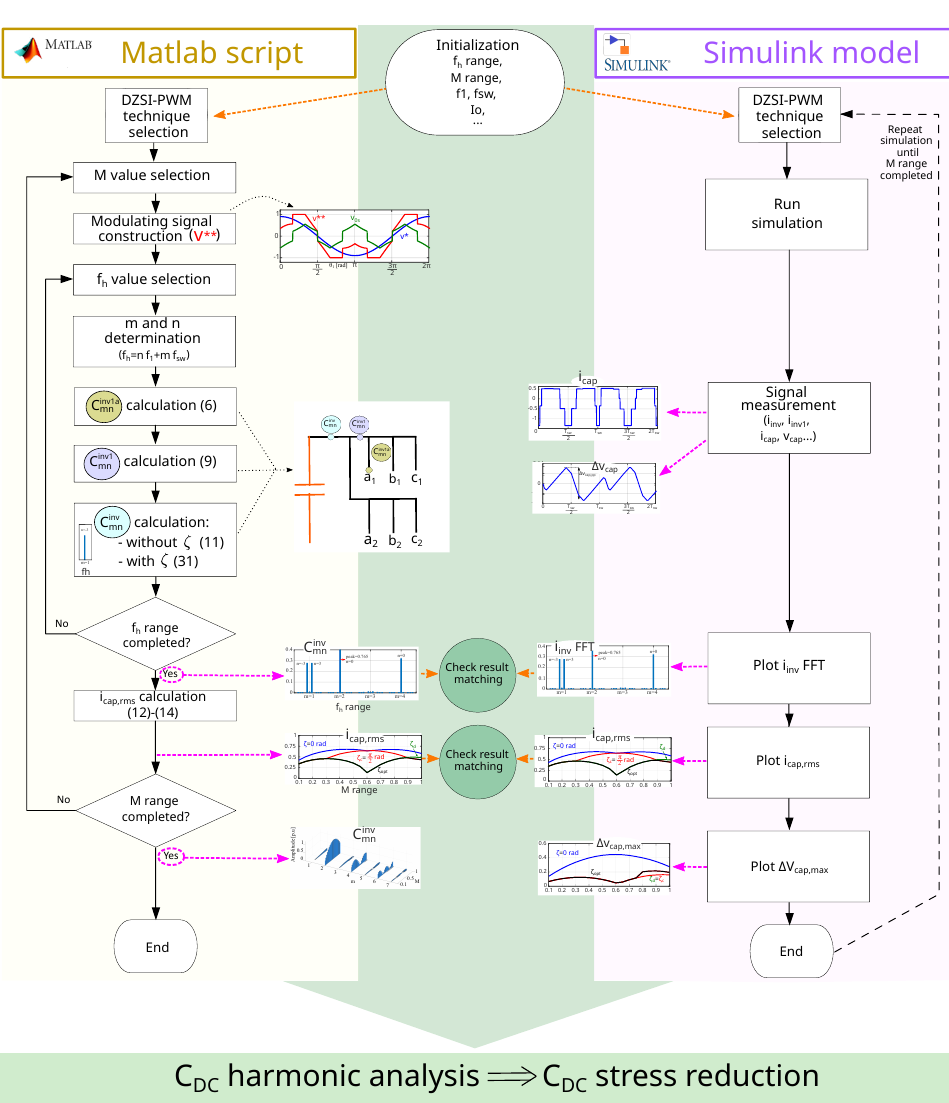
Figure 3. C DC harmonic analysis and rms calculation flow